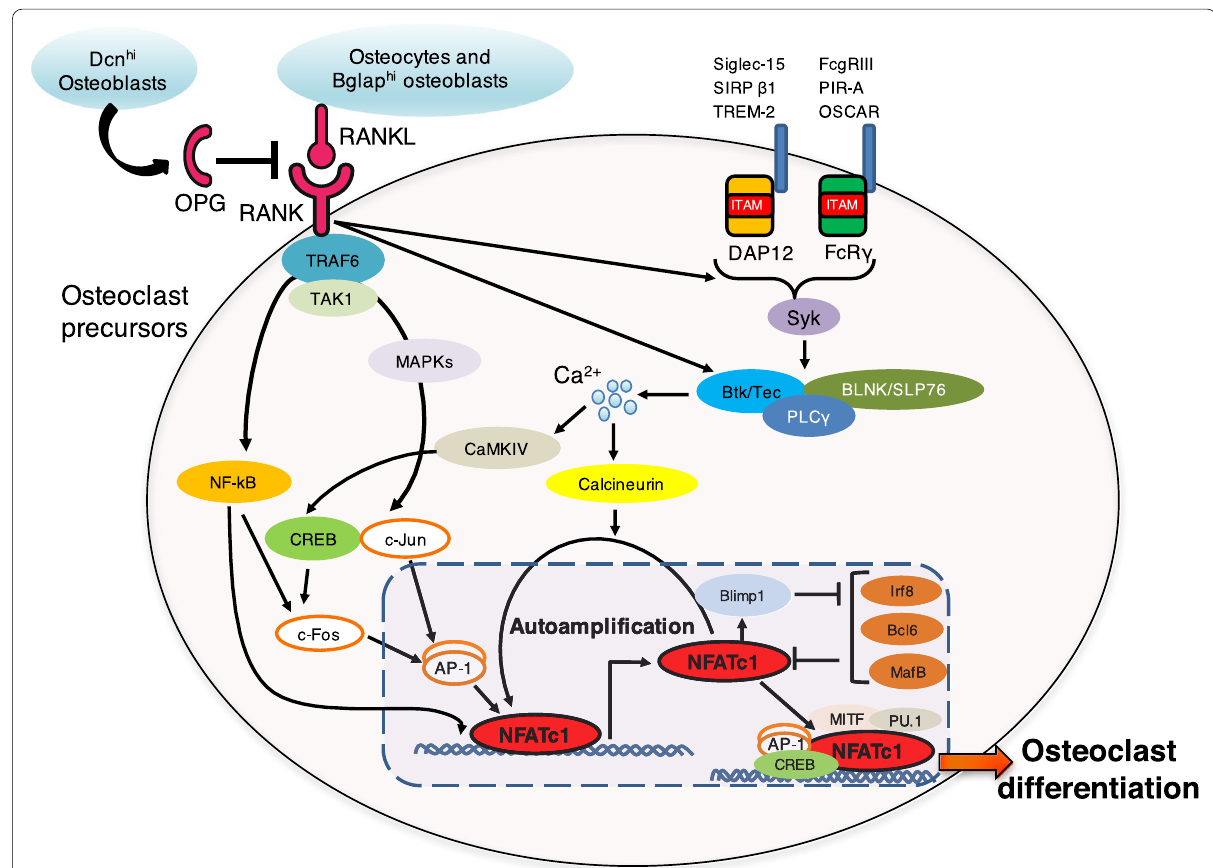
Fig. 2 Molecular mechanisms underlying osteoclast differentiation. RANKL, the master regulator of osteoclastogenesis, is expressed by osteocytes and Bglap hi osteoblasts. Dcn hi osteoblasts locally produce OPG to inhibit osteoclast differentiation and activation. RANKL binding to RANK expressed by osteoclast progenitors results in the activation of signaling cascades including MAPK and NF-κB pathways via TRAF6 and TAK1. The RANKL/RANK signal cooperates with signaling from ITAM-containing immunoglobulin-like receptors such as TREM-2, SIRP ββ, Siglec-15, OSCAR, PIR-A, and FcγRIII. These signaling cascades ultimately lead to the auto-amplification of NFATc1, the master transcription factor of